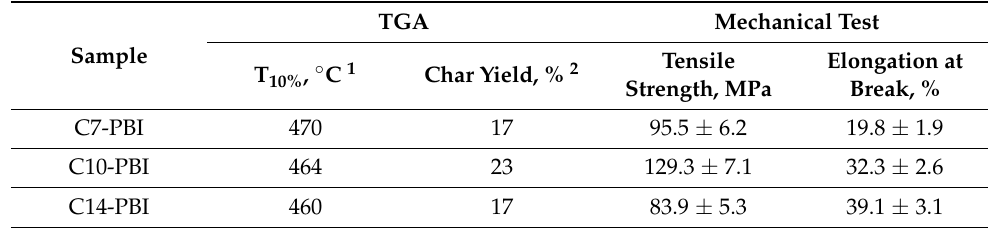
Table 2. Thermal and mechanical properties of